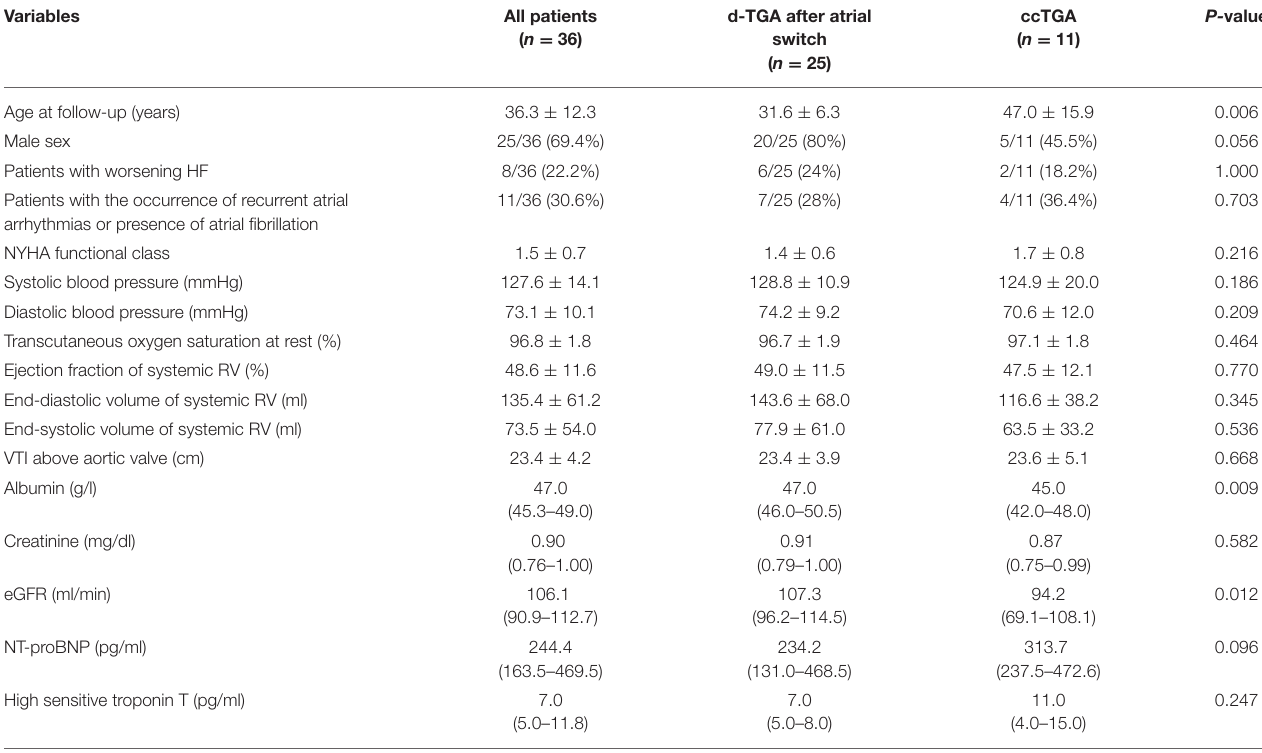
TABLE 1 | Characteristics of TGA-RV patients according to the underlying heart defect. Variables All patients